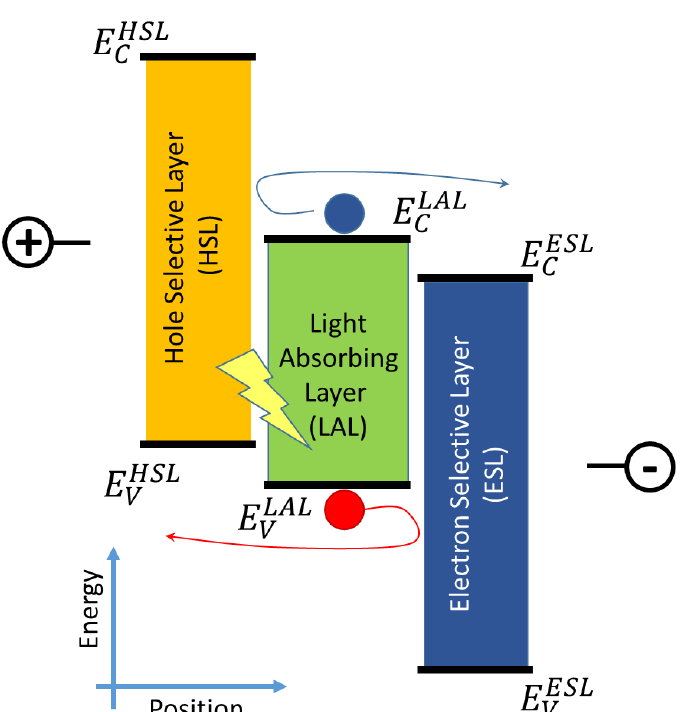
Fig. 2. – Schematic diagram of key elements for solar cells. Three, eventually different, materials are used for the Hole Selective Layer (HSL) the Electron Selective Layer (ELS) and the Light Absorbing Layer (LAL). The coloured areas depict the bandgap of the materials while E ..L E ..L the conduction and valence edges of the layer L , V